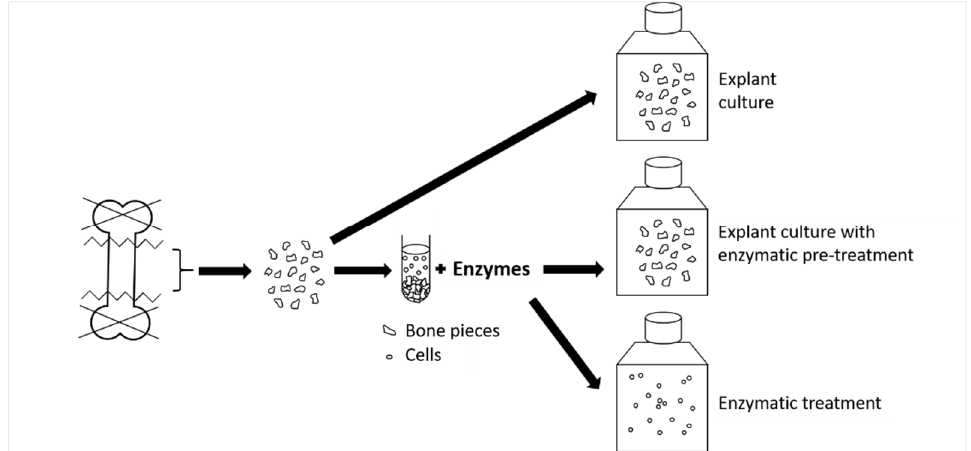
Figure 10. Schematic representation of the used rOBs isolation methods: explant culture, explant culture with enzymatic pre-treatment, and enzymatic treatment.